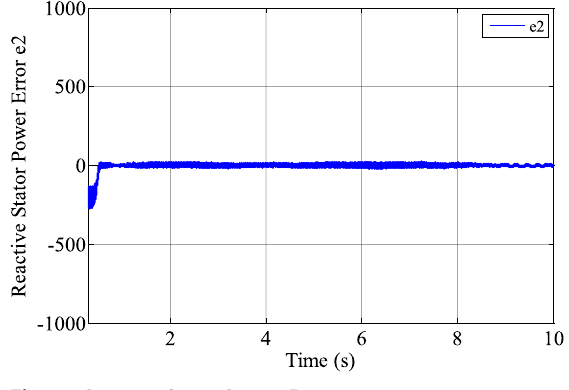
Fig. 14 Reactive Stator Power Error e2